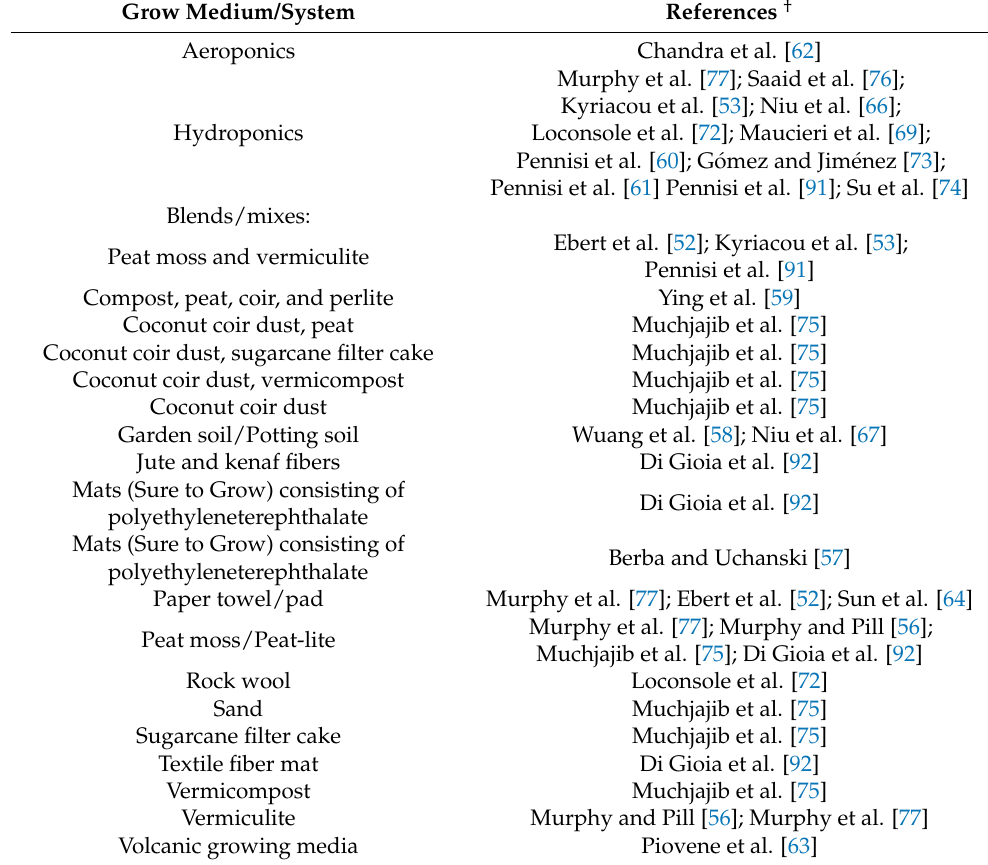
Table 3. Grow media or systems examined for indoor leafy vegetable production † . Grow